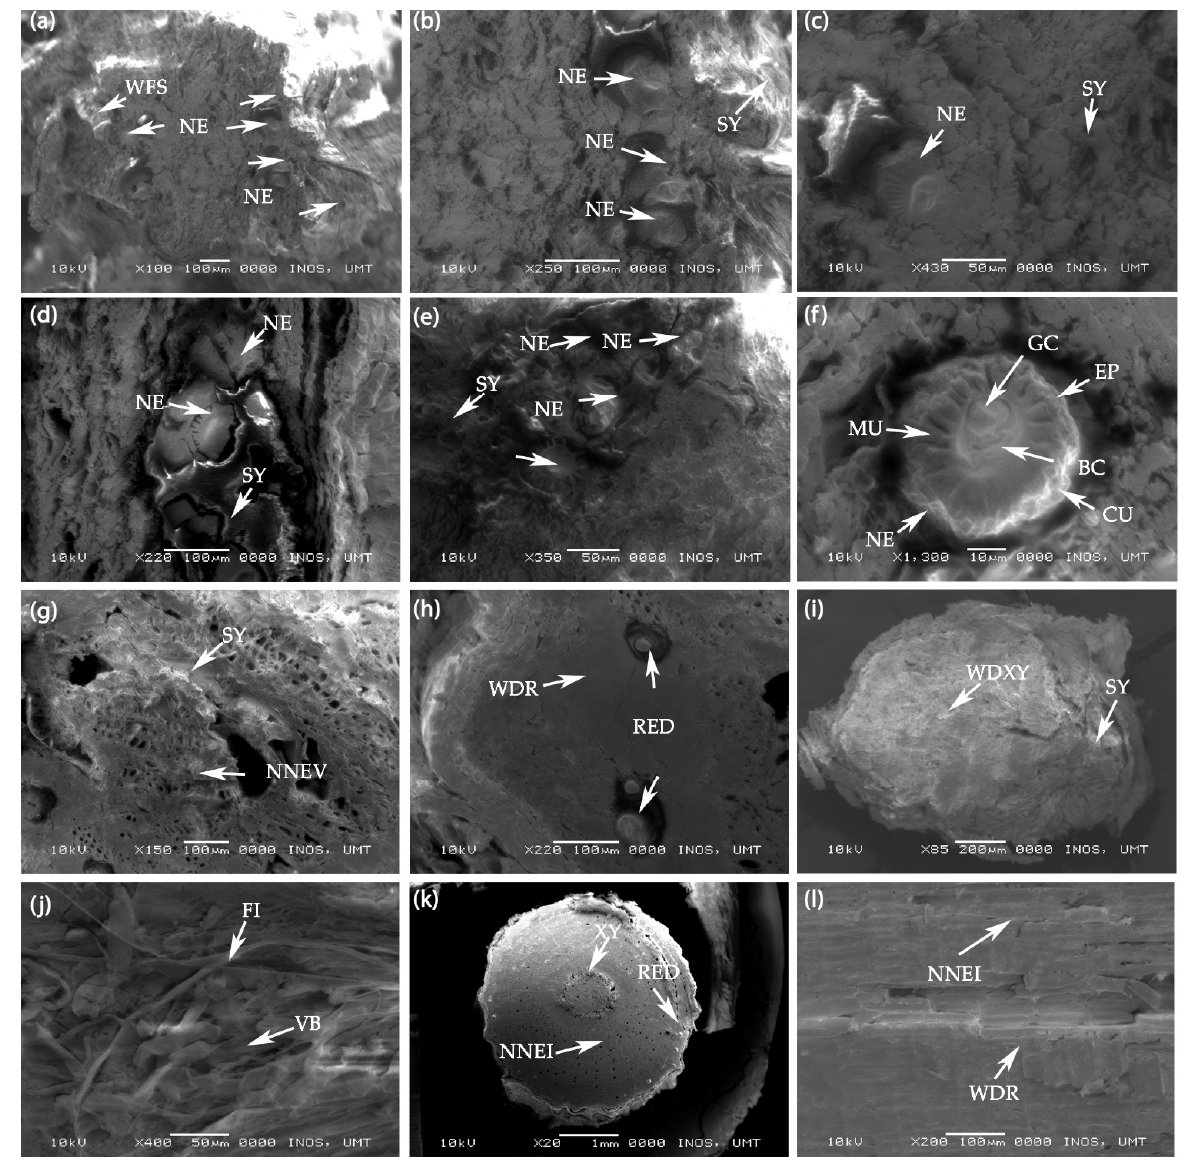
Figure 8. ( a – c ) Scanning electron microscopy (SEM) photographs of the swollen galls (cross section) in the root of untreated F. deltoidea plant. Syncytia cells and many nematodes are visible in the control plants. Abbreviations: WFS—